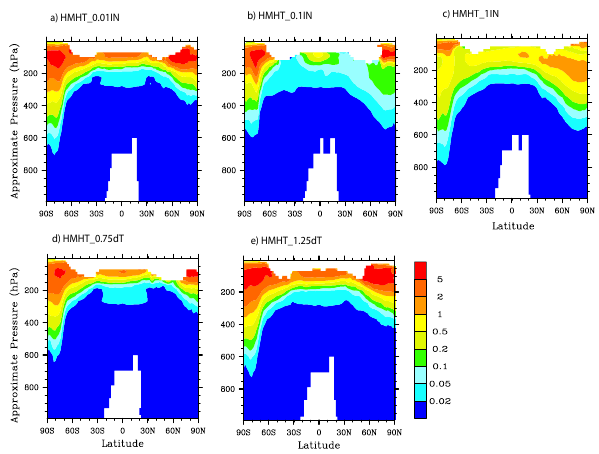
Figure 10 Fig. 10. Annual average zonal mean ice crystal number concen- tration (#/cm 3 ) in all five cases that allow the competition between homogeneous freezing and heterogeneous freezing. All cases are described in Table